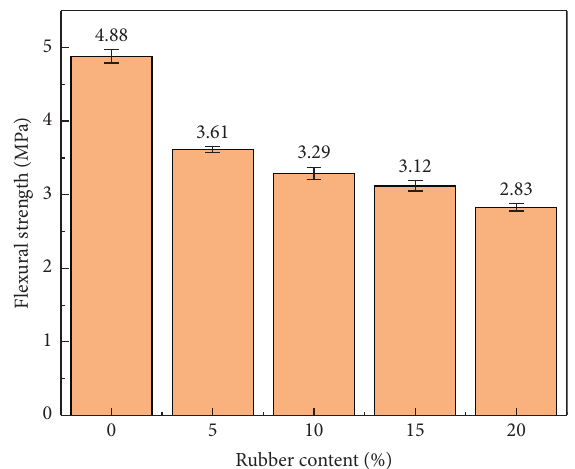
Figure 10: Damping ratio of fiber concrete with different rubber powder